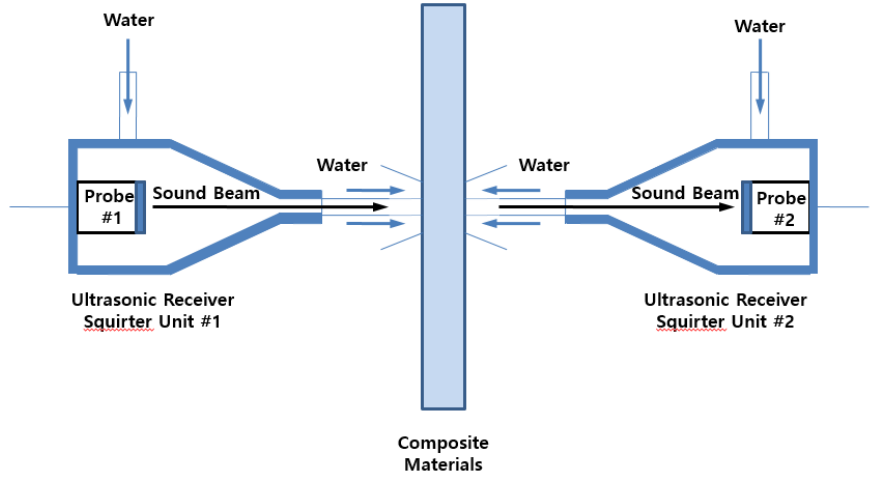
Figure 1. Through-transmission ultrasonic method with squirter.